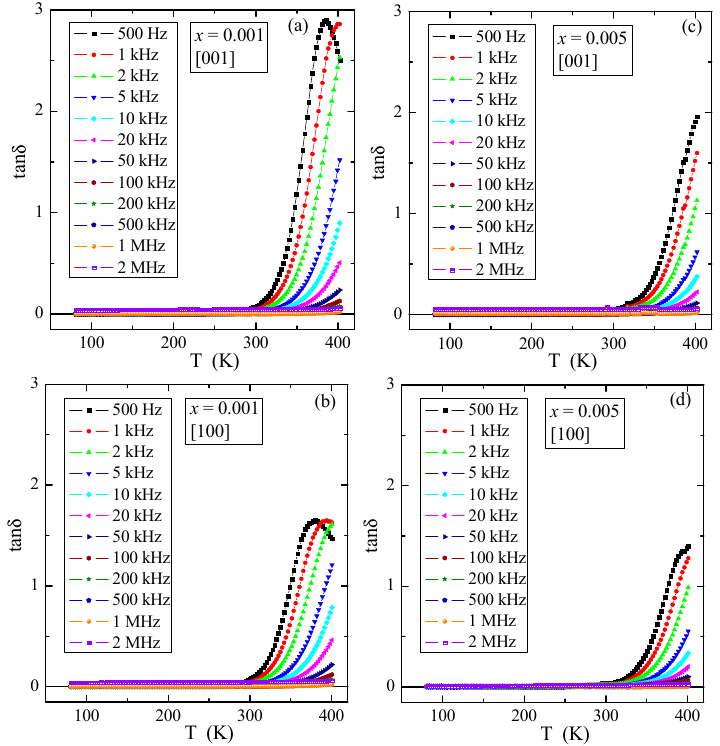
Figure 10. Loss tangent tan δ vs. temperature T of PNMWO single crystals: ( a ) x = 0.001 and [001], ( b ) x = 0.001 and [100], ( c ) x = 0.005 and [001], ( d ) x = 0.005 and [100].